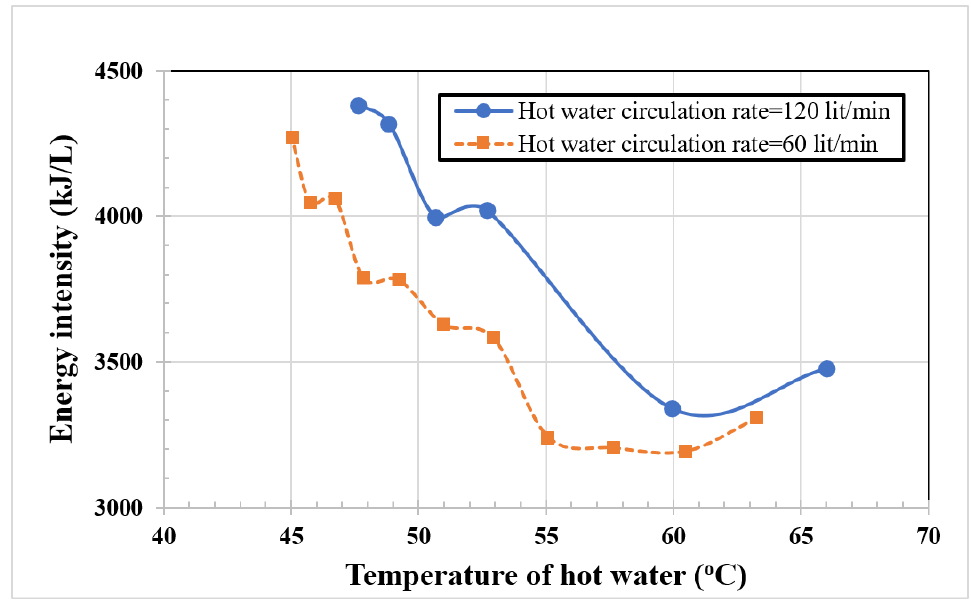
Figure 15. Energy intensity versus hot seawater temperature at two levels of seawater flow rate.